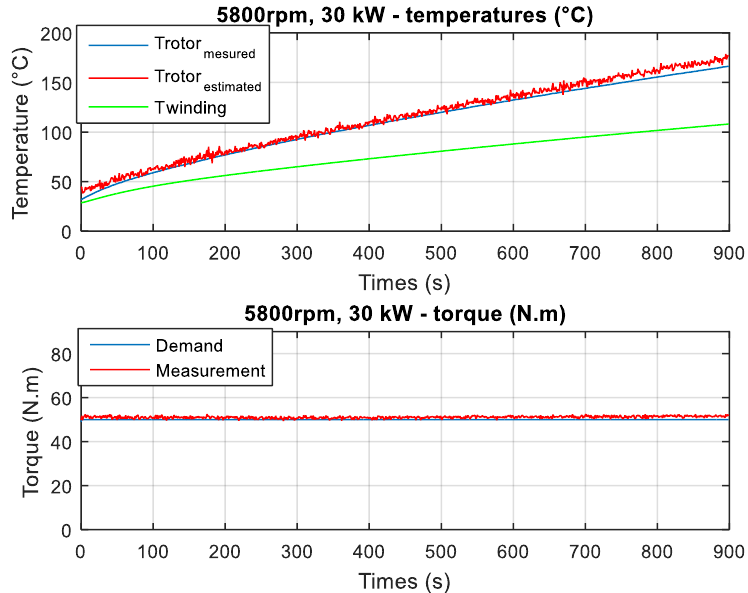
Figure 8. Comparison of the temperatures found by estimator against pyrometer and torques for 30 kW at 300 Vdc and 5800 rpm.